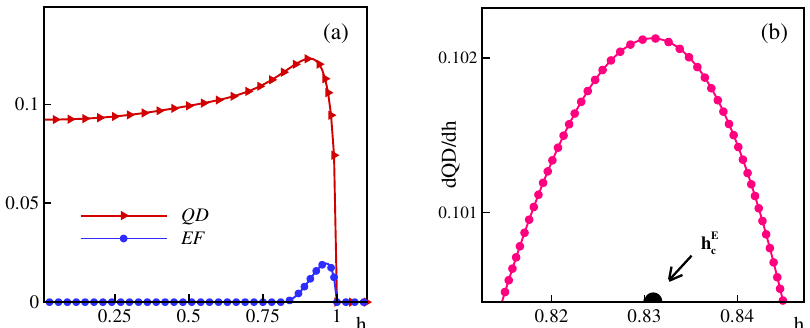
Figure 3. ( a ) QD and EF; and ( b ) first derivative of the QD in the vicinity of h E c as a function of magnetic field for the 3N pairs at zero temperature.